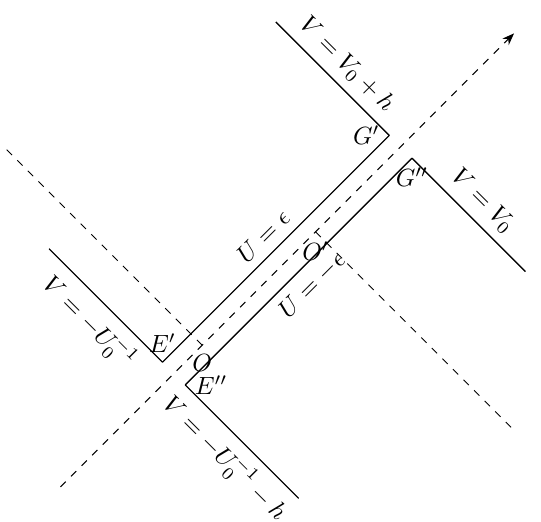
Figure 6. Illustration of the treatment of the discontinuity along null segement EG . We take the limit (cid:15) ! 0 so the null segement E 0 G 0 and E 00 G 00 approach to EG in the same